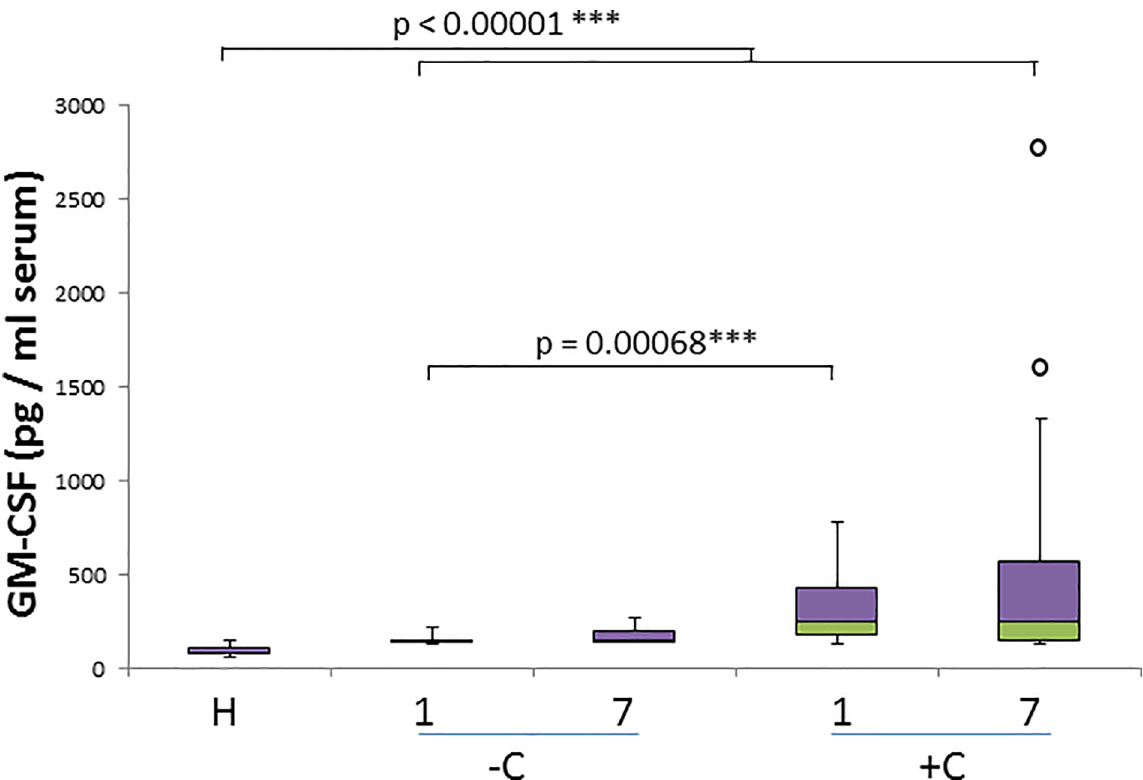
Fig 7. GM-CSF concentration in healthy and naturally infected dogs and its relation with outcome. Box and whisker plot with outliersshowinginterquartile range (median bar in intersect betweentwo colors in box) of GM-CSF concentration values among different groups: healthydogs (H), uncomplicated (-C) and complicated (+C) cases for both day 1 and day 7. Mann-whitney test p- values are shown for comparisonof different groups.